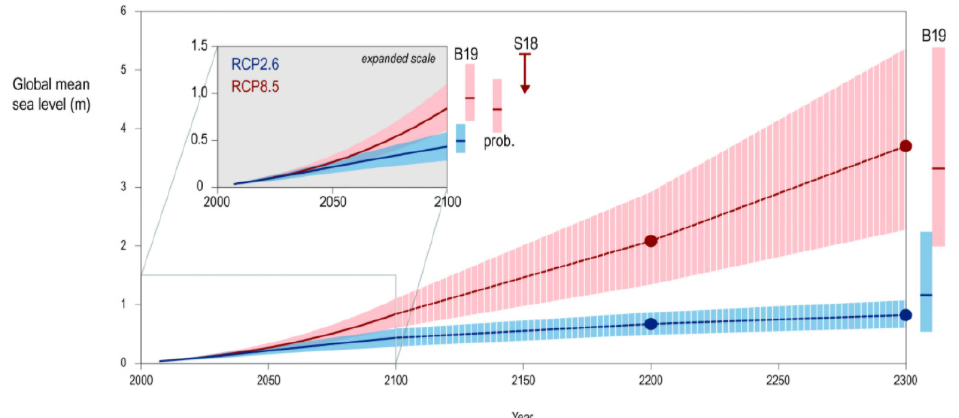
Figure 5. Predicted global sea level rise (GMSL) to 2300. Projections relate to a range of Representative Concentration Pathway Emissions scenarios (RCP), which reflect global mean temperature increases of between 2 and 5 ◦ C. See original reference for details re-probabilistic modeling shown as bars such as S18 and B19. Note the ranges in estimated sea level rises of c. 0.2–1 m in 2100, and 1.7–>5 m by 2300. Acknowledgements: IPCC and Cambridge University Press for the use of this figure